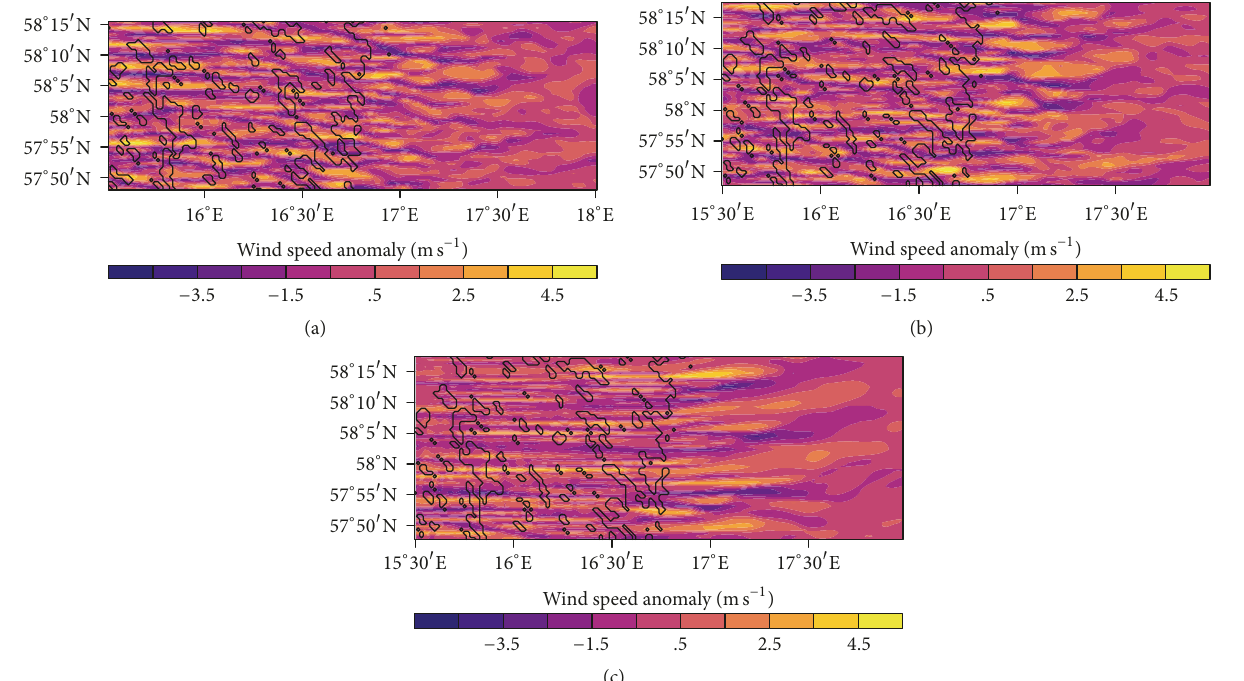
Figure 10: Horizontal wind speed anomaly from simulations with different sea surface temperatures at 14 UTC. (a) Default. (b) SST-2 ∘ C. (c) SST-4 ∘